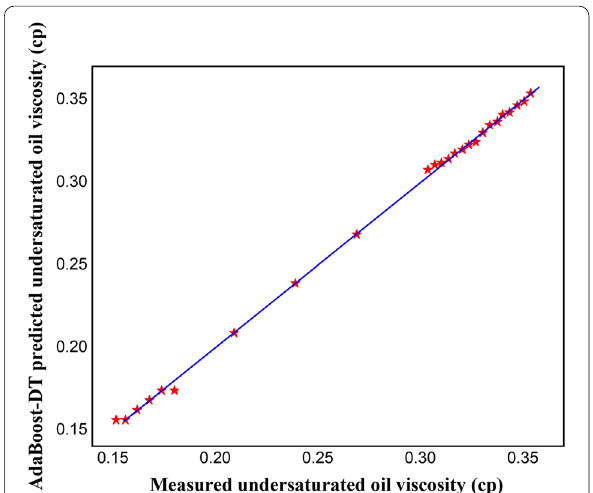
Fig. 18 Cross plot of AdaBoost-DT predicted values versus measured values